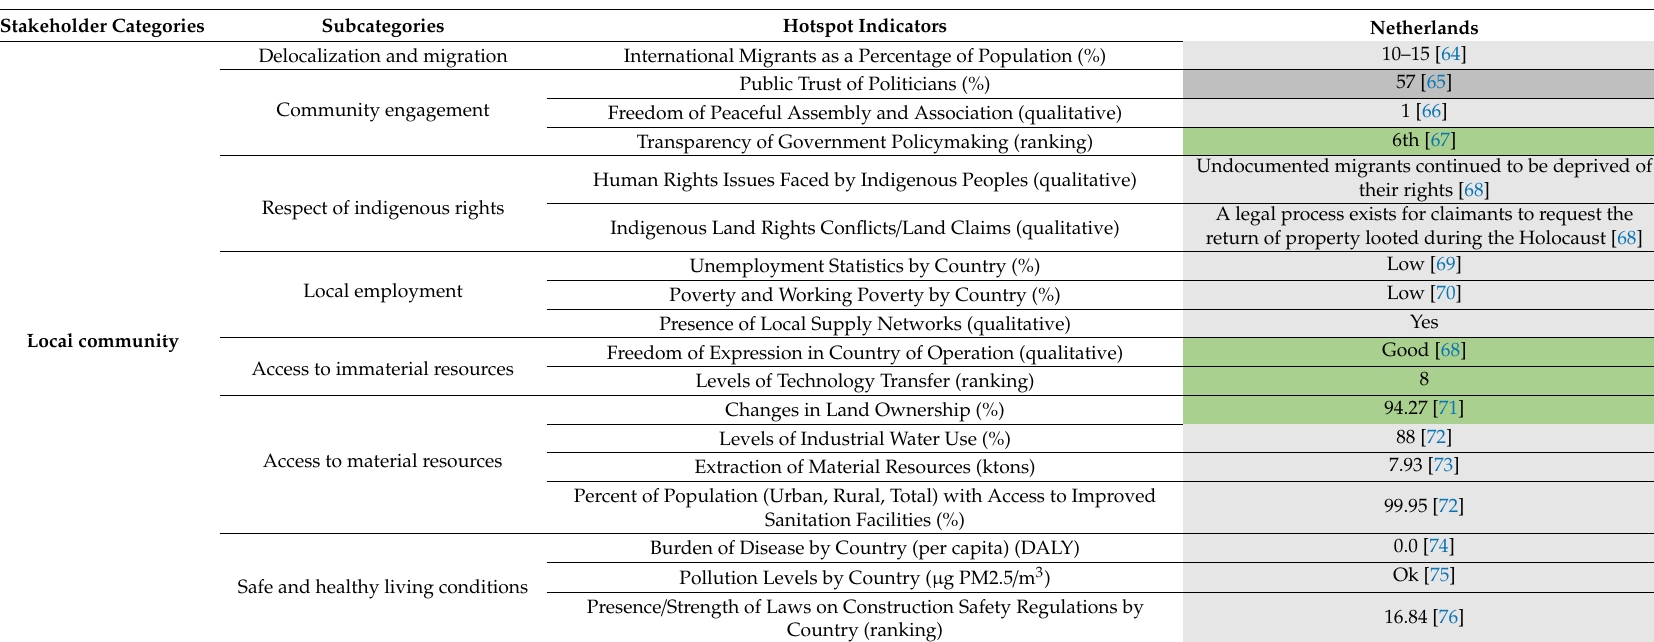
Table 1. Social performance based on the scoring scheme of Figure 2 of the Dutch energy sector with current S-LCA indicators, adapted from [43] and modified based on the Goal and